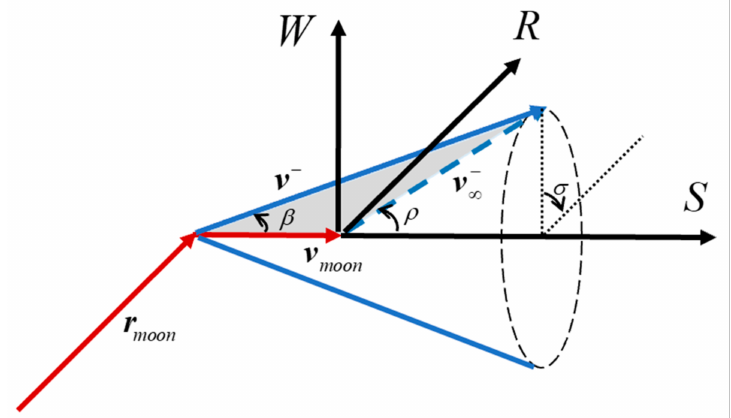
Figure 6. Velocity geometric relationship at lunar